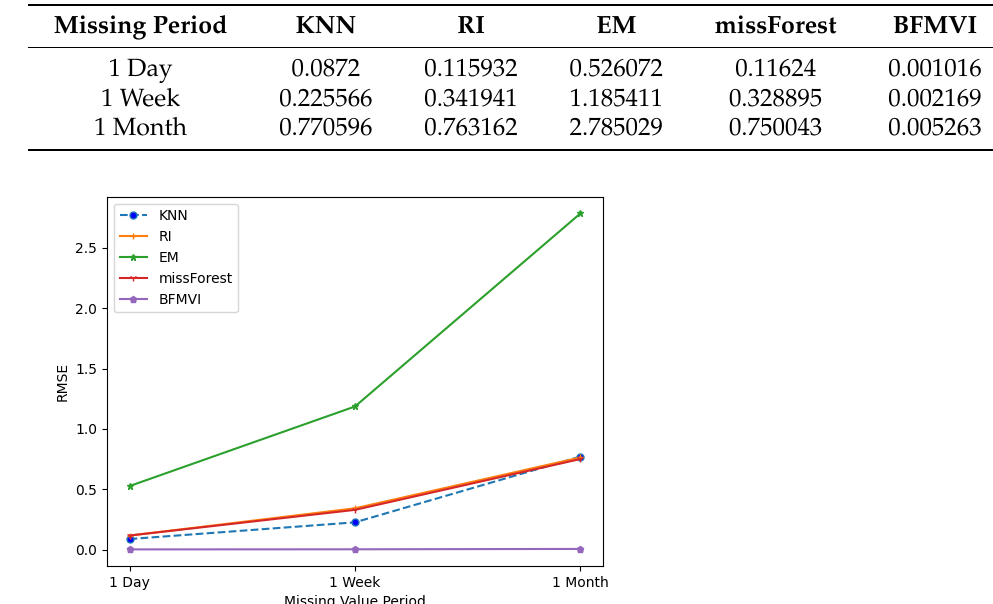
Table 2. Comparison of Imputation Techniques on C 6 H 6 Missing Values occurring over Consecutive Periods.